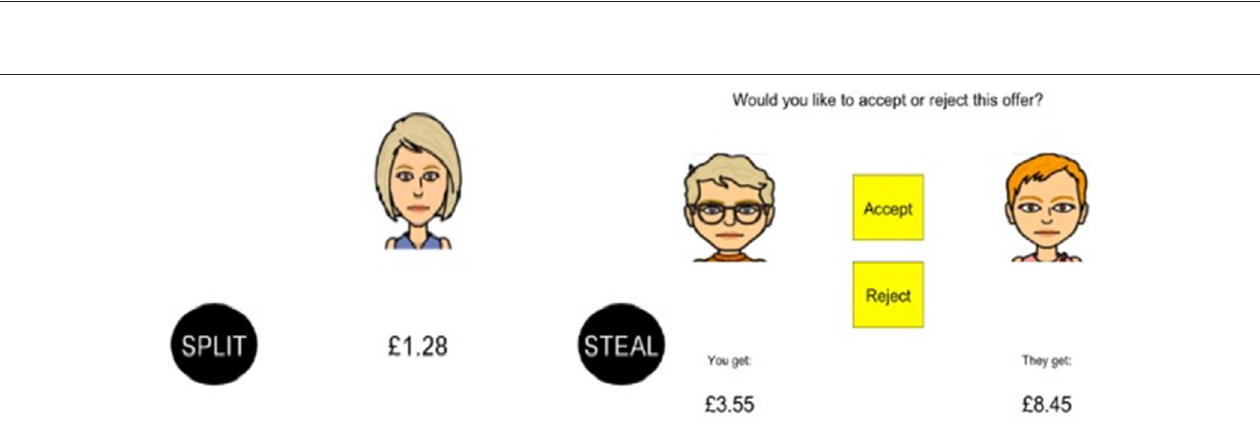
FIGURE 2 | Examples of offers from the Prisoner’s Dilemma (left) and Ultimatum Game (right).